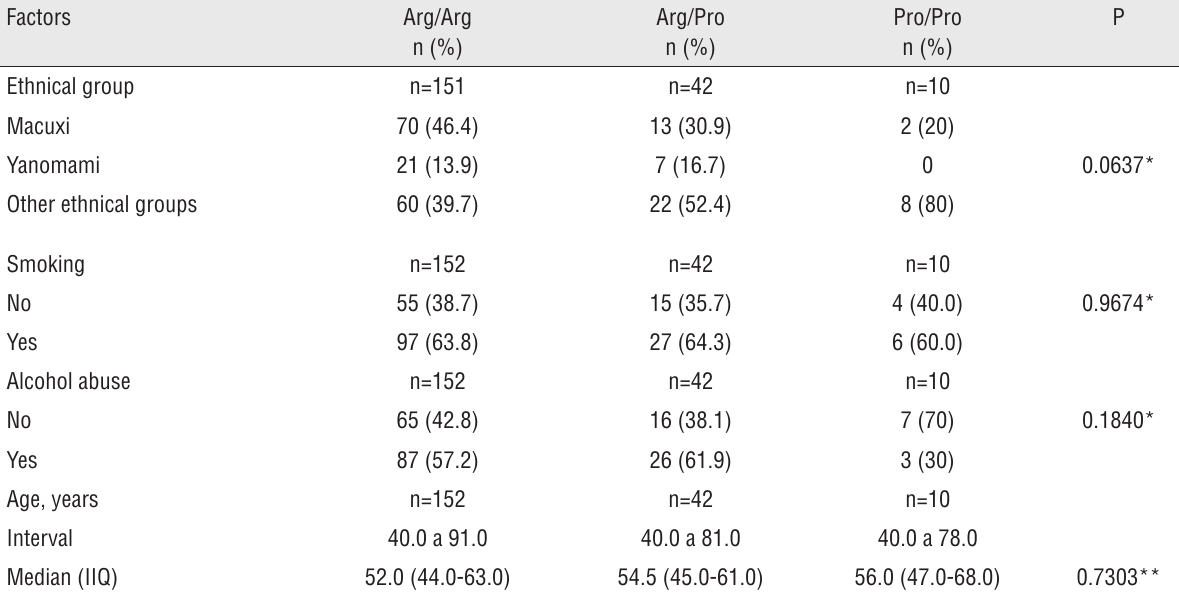
Table 5 - Demographic and clinical characteristics according to P53